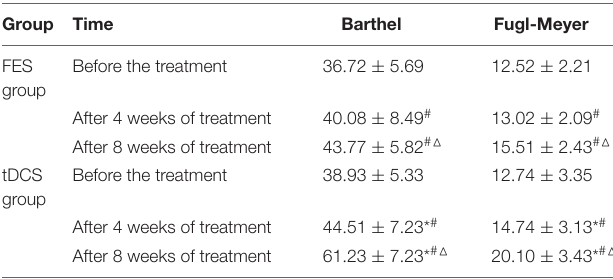
TABLE 2 | The difference test before treatment, 4 weeks after treatment, and 8 weeks after